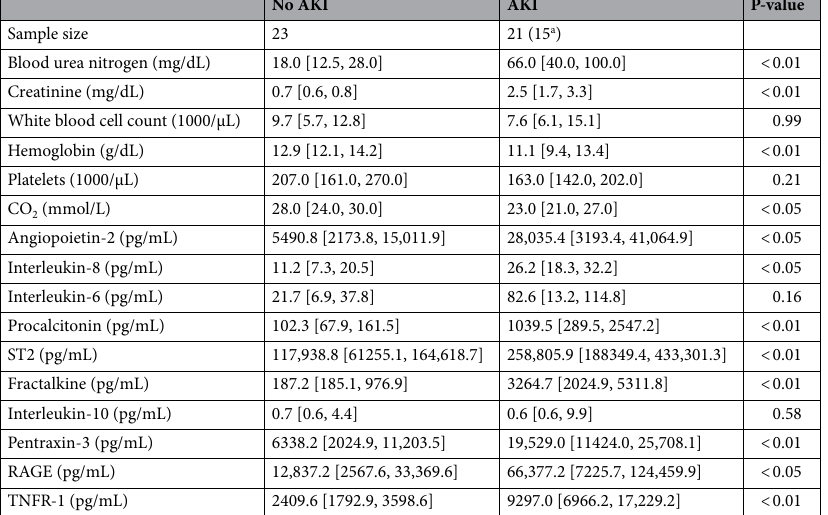
Table 3. Summary of blood chemistry and biomarkers of inflammation. a Sample size for plasma biomarkers using Luminex analysis was 15. Values are median and interquartile